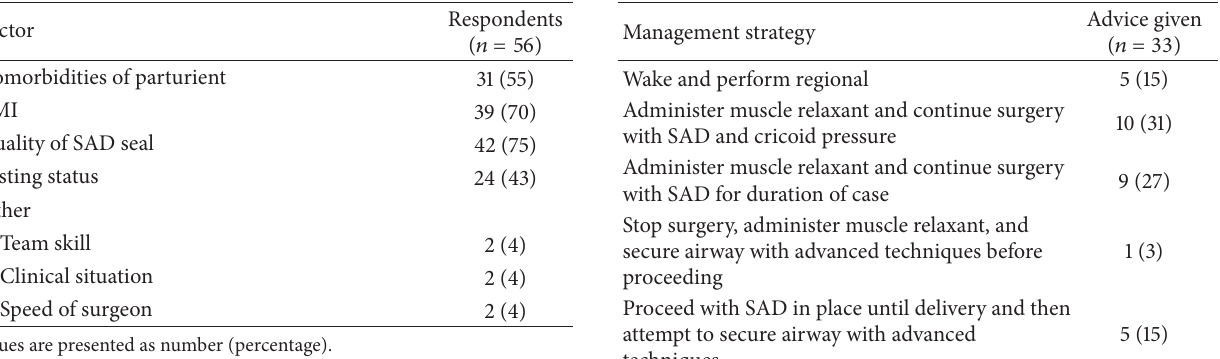
Table 3: Factors influencing the decision to continue caesarean delivery with supraglottic airway device, for anaesthetists that would consider continuing surgery.